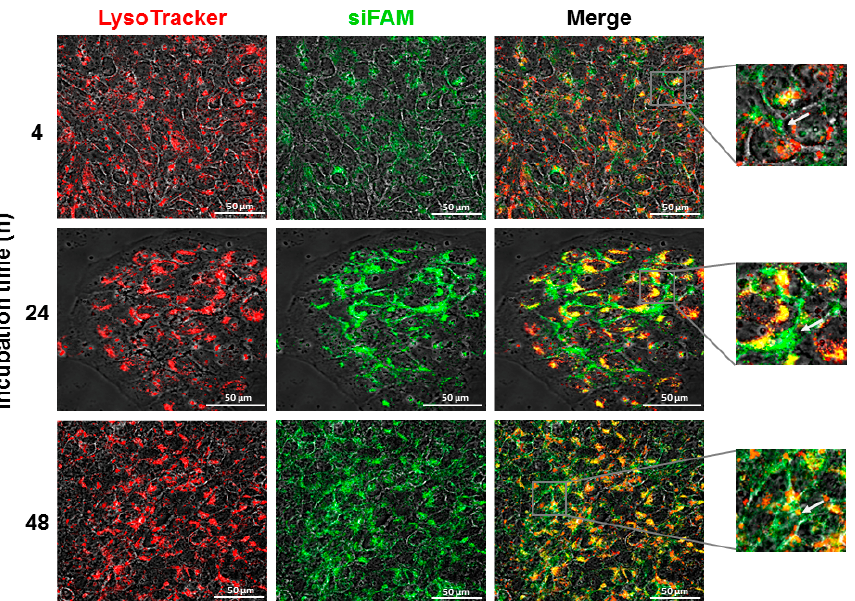
Figure 10. The time-dependent internalization (confocal microscopy) and intracellular fate of Lip DOPE -siRNA in keratinocytes (HaCaT) cell culture. Cells were treated with 6 µg/mL (siRNA concentration) and examined for siRNA endosomal/lysosomal escape. The endo-lysosomes are depicted in red (LysoTracker Red DND-99), fluorescently-labeled siRNA (siFAM) is depicted in green, and colocalization is depicted in yellow (white arrows). The fluorescence intensity was normalized to untreated cells; magnification ×60 (scale bar = 50 µm).